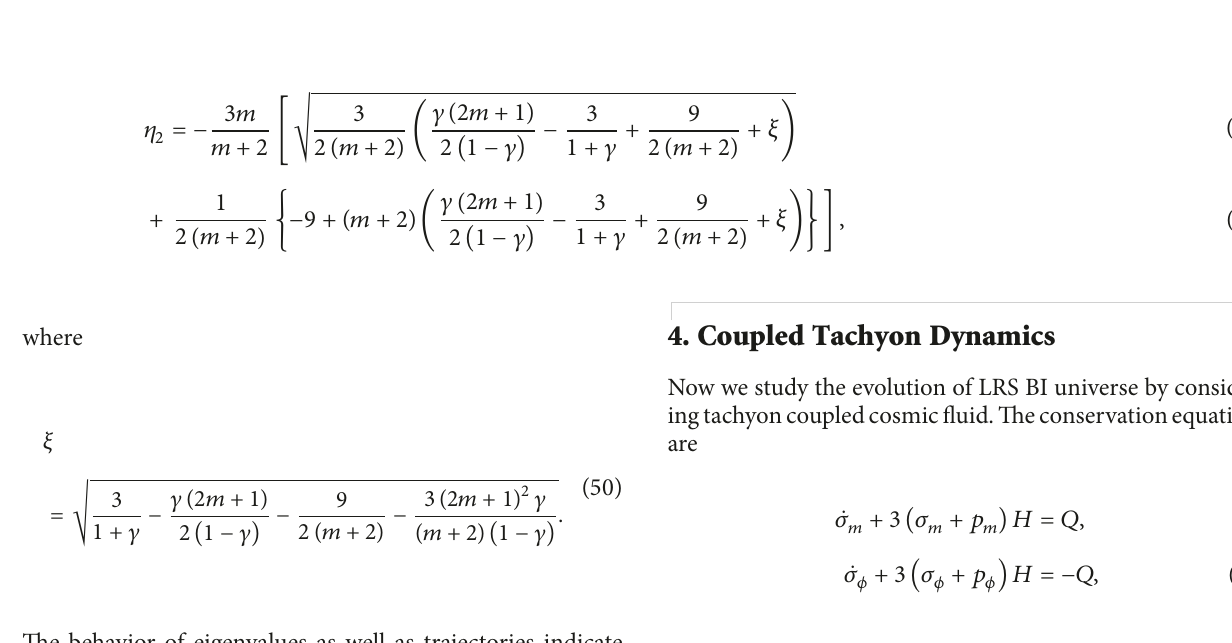
Figure 3: Plots for phantom coupled cosmic model with 𝑄 = 𝛾( ̇𝜎 𝑚 + ̇𝜎 𝜙 ) and 𝜆 = 1.5